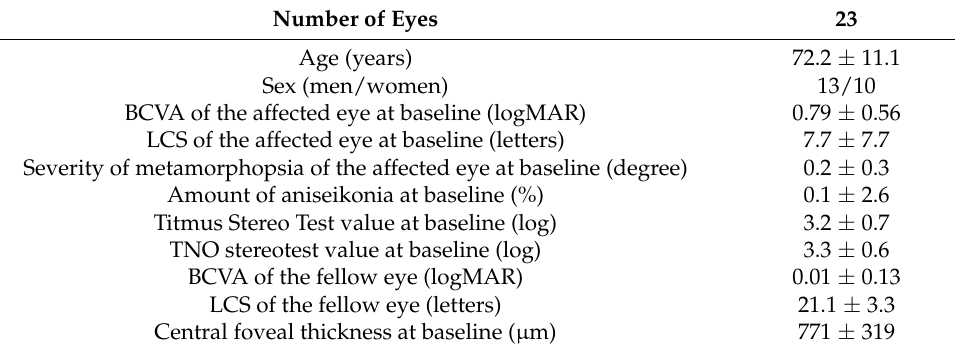
Table 1. Baseline clinical characteristics of